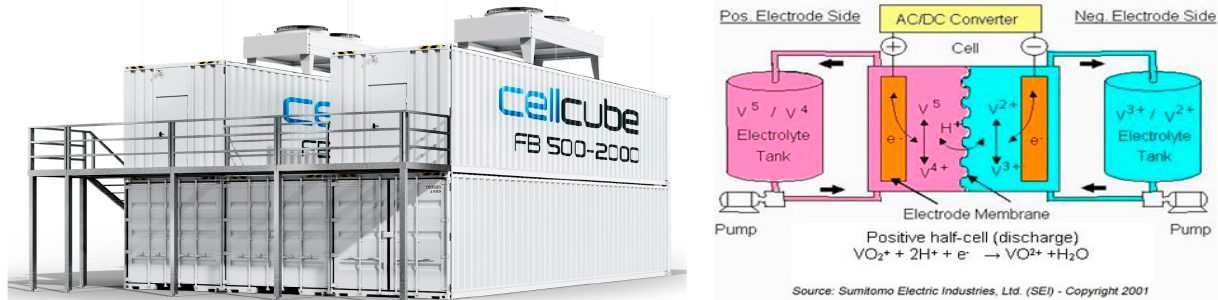
Figure 21. A better vanadium flow battery [41,42].